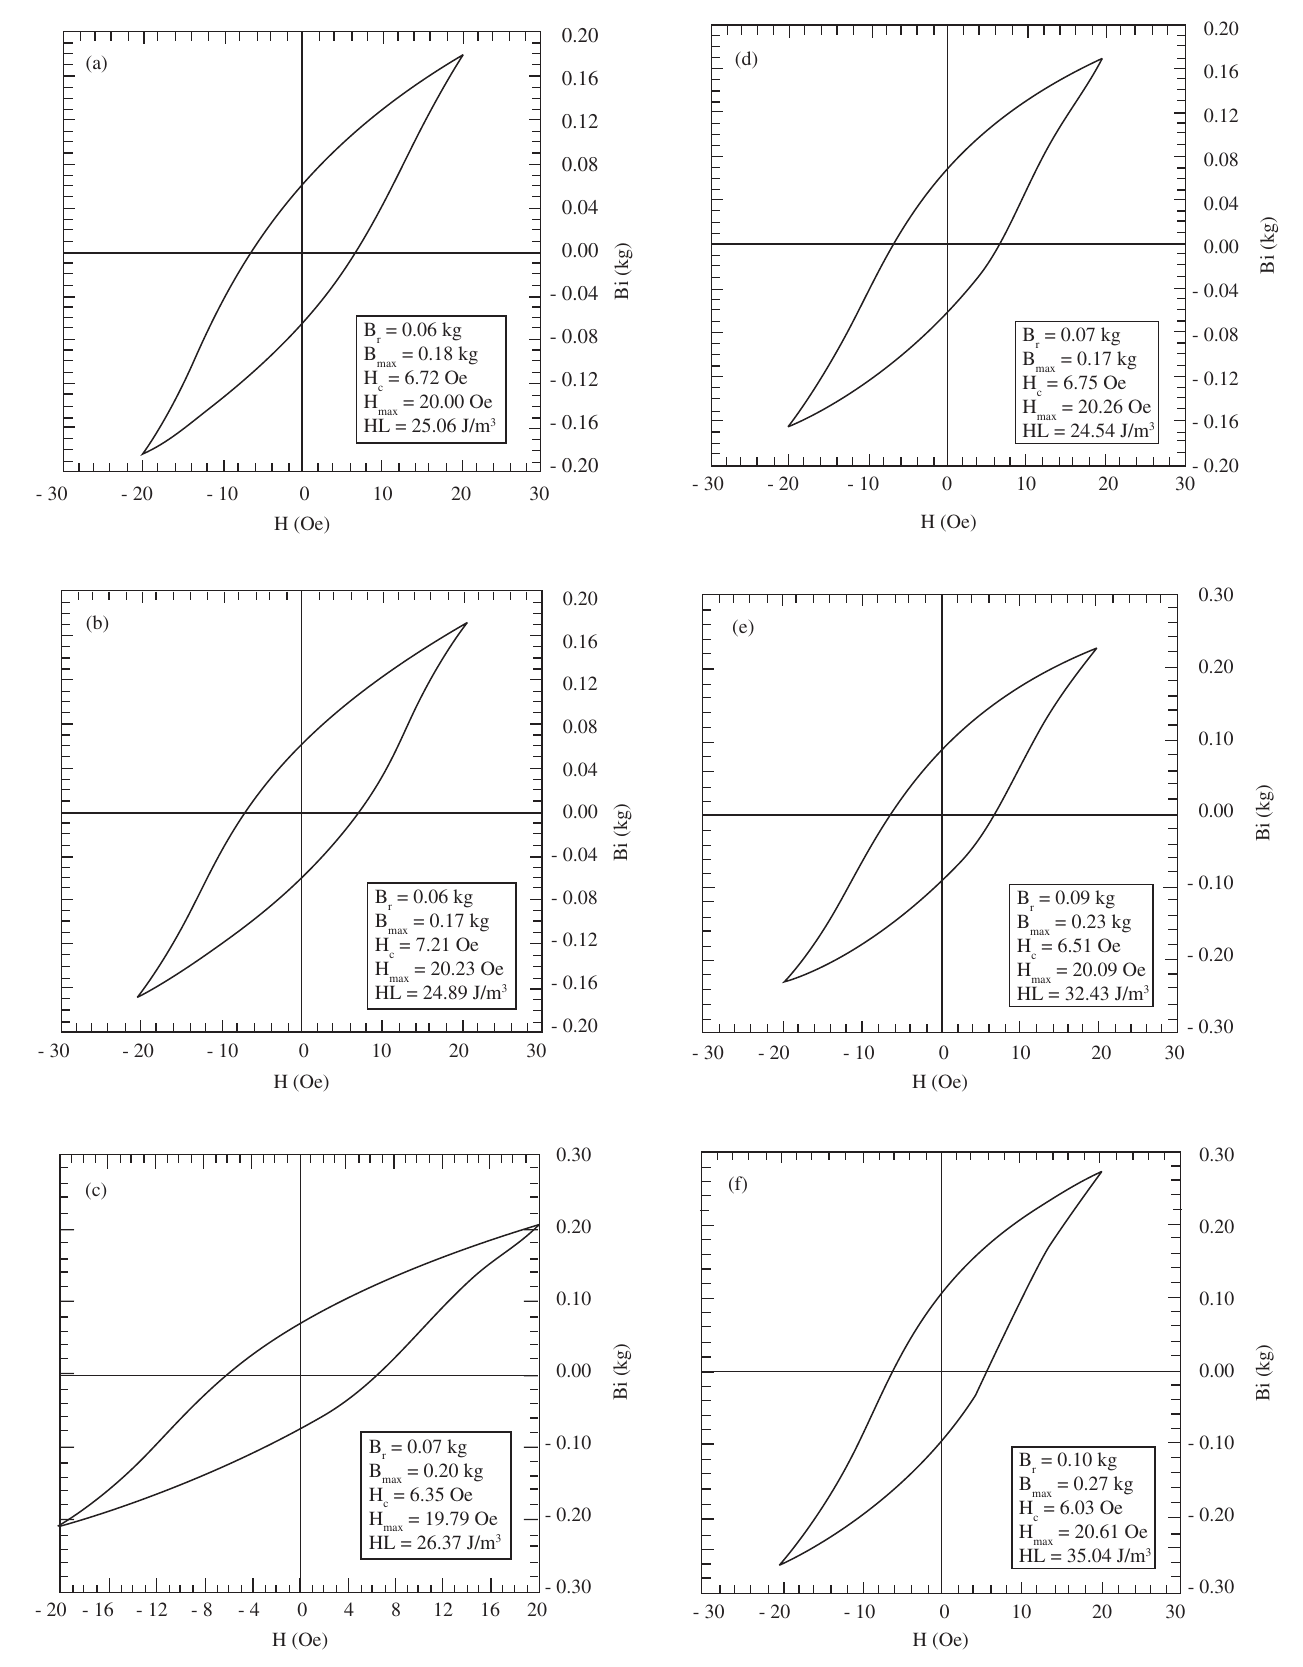
Figure 4. Magnetic hysteresisgraphs of cobalt-zinc ferrite rings sintered for 5 hours at: a) 950 °C; b) 1100 °C; c) 1200 °C; d) 1300 °C; e) 1350 °C; and f) 1400 °C. Frequency = 60